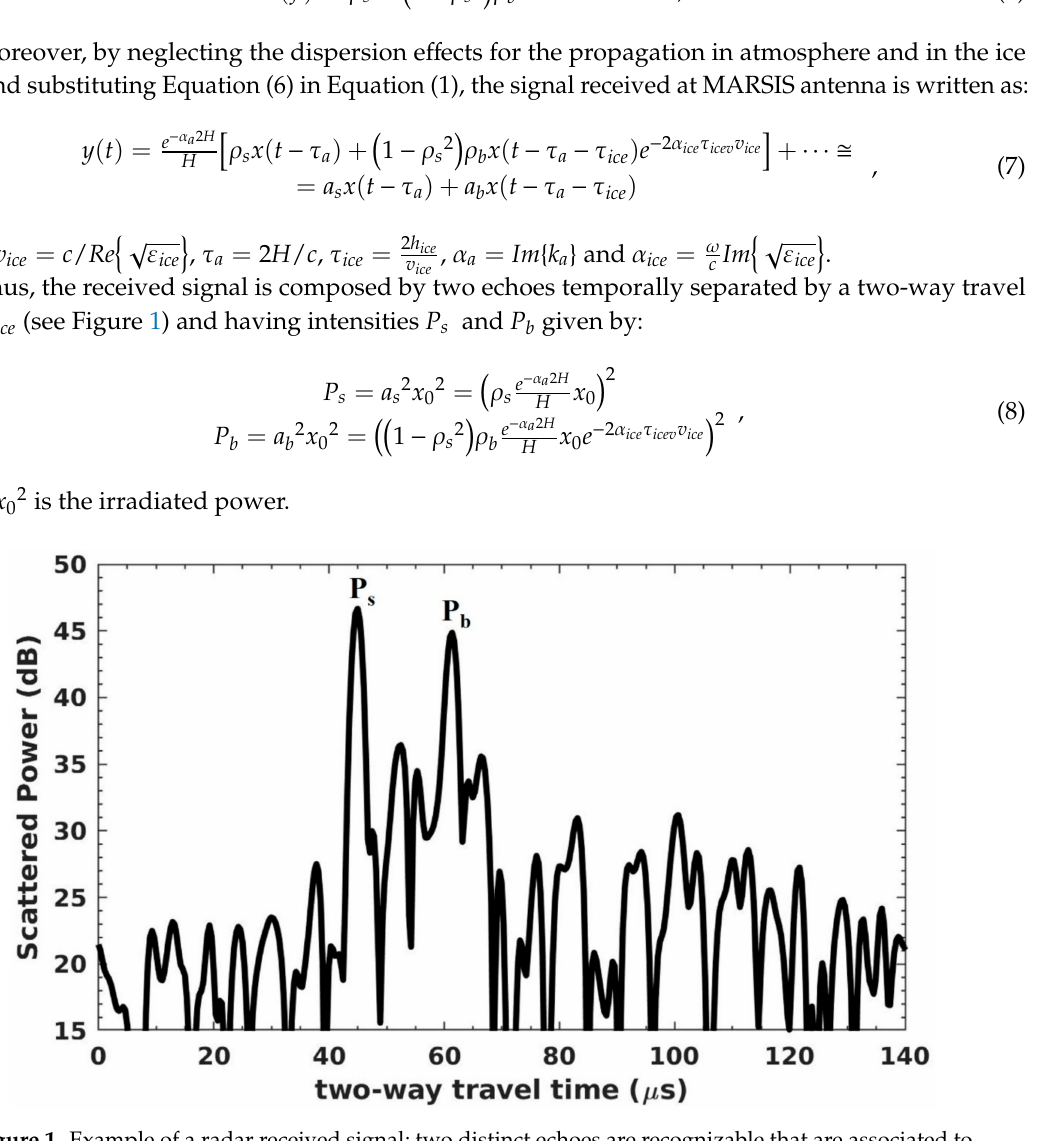
Figure 1. Example of a radar received signal; two distinct echoes are recognizable that are associated to the reflections at the surface and the base of the South polar layered deposits